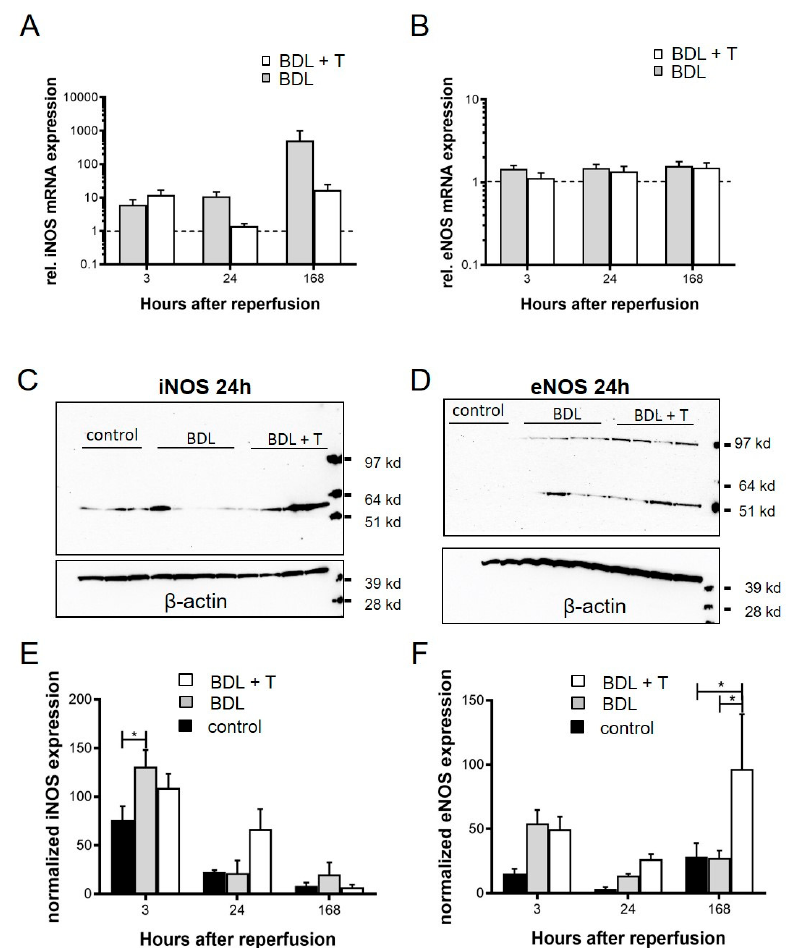
Figure 5. For the analysis of the effect of the L-NAME treatment (BDL + T) inducible nitric oxide synthase (iNOS) and endothelial nitric oxide synthase (eNOS) mRNA levels ( A , B ) and protein expression ( C , D ) were determined and quantified by densitometry ( E , F ). Relative mRNA expression of iNOS (A) and eNOS (B) were measured by RT-qPCR after 3, 24, and 168 h after reperfusion (C, D). Results of protein expression in Western blots are shown 24 h after reperfusion. Densitometry analysis of Western blot results of iNOS (E) and eNOS (F) protein expression. β -actin normalized expression of iNOS and eNOS after 3, 24, and 168 h after reperfusion are shown. Mean and standard deviation are shown in each group with significance levels of * p <